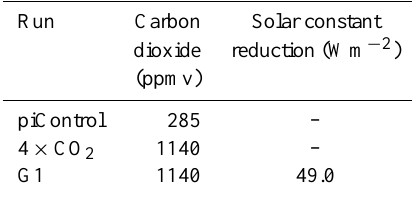
Table 1. Overview of the simulations. Run Carbon Solar constant dioxide reduction (Wm − 2 ) (ppmv) piControl 285